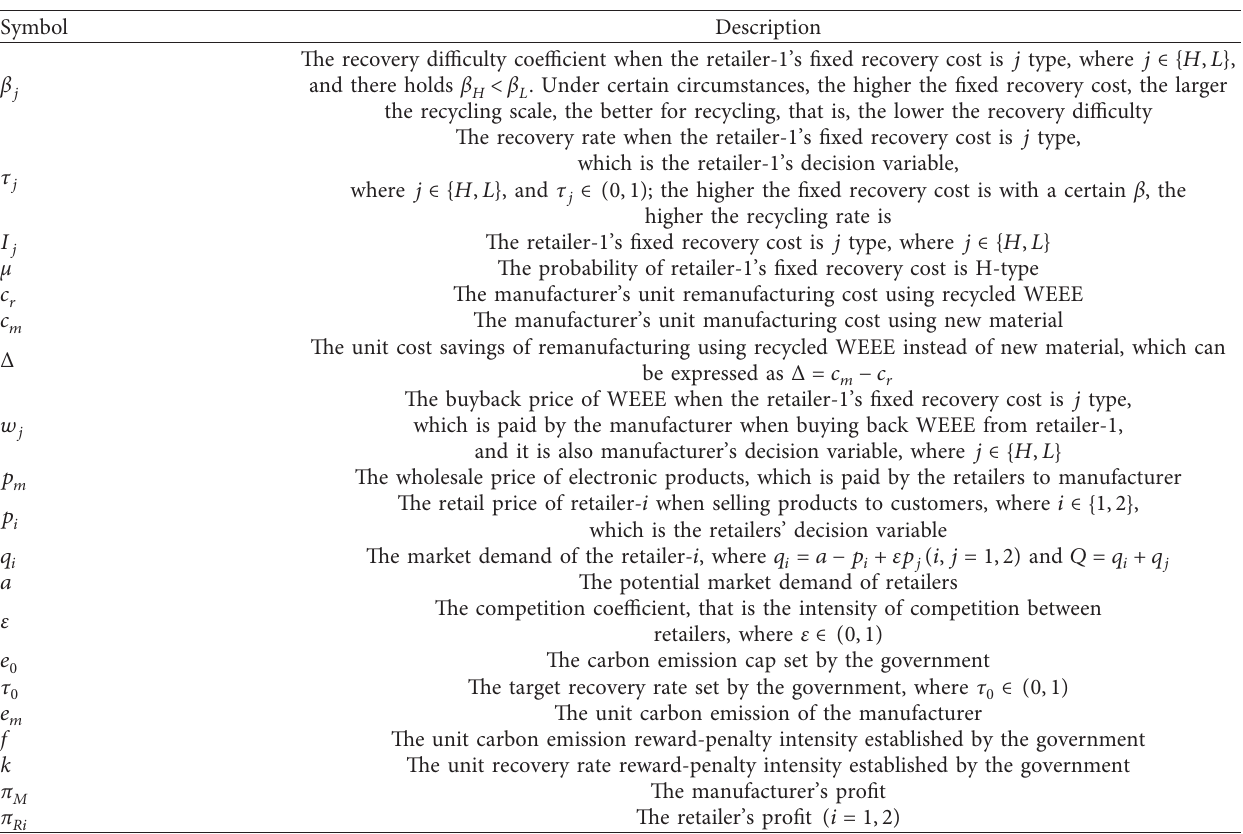
f and k R 1 and π R 2 vs.